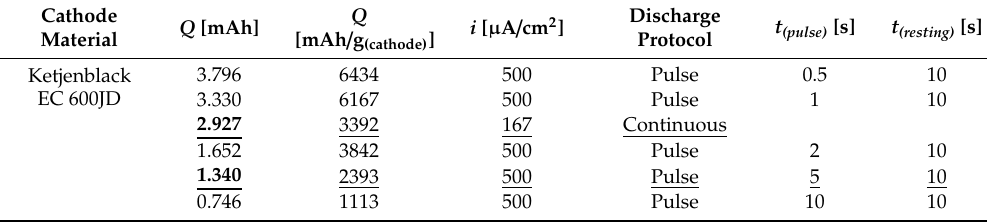
Table 2. Summary of the pulse discharge and continuous discharge experiments with self-made two-dimensional Ketjenblack EC 600JD cathodes for the formation of NaO 2 . For the three-battery setup comparison between pulse discharging and continuous discharging the values are highlighted in bold,